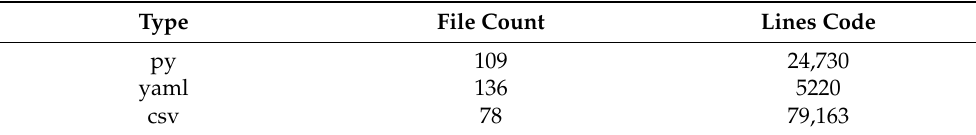
Table 5. FLOWSA v1.2.1 code